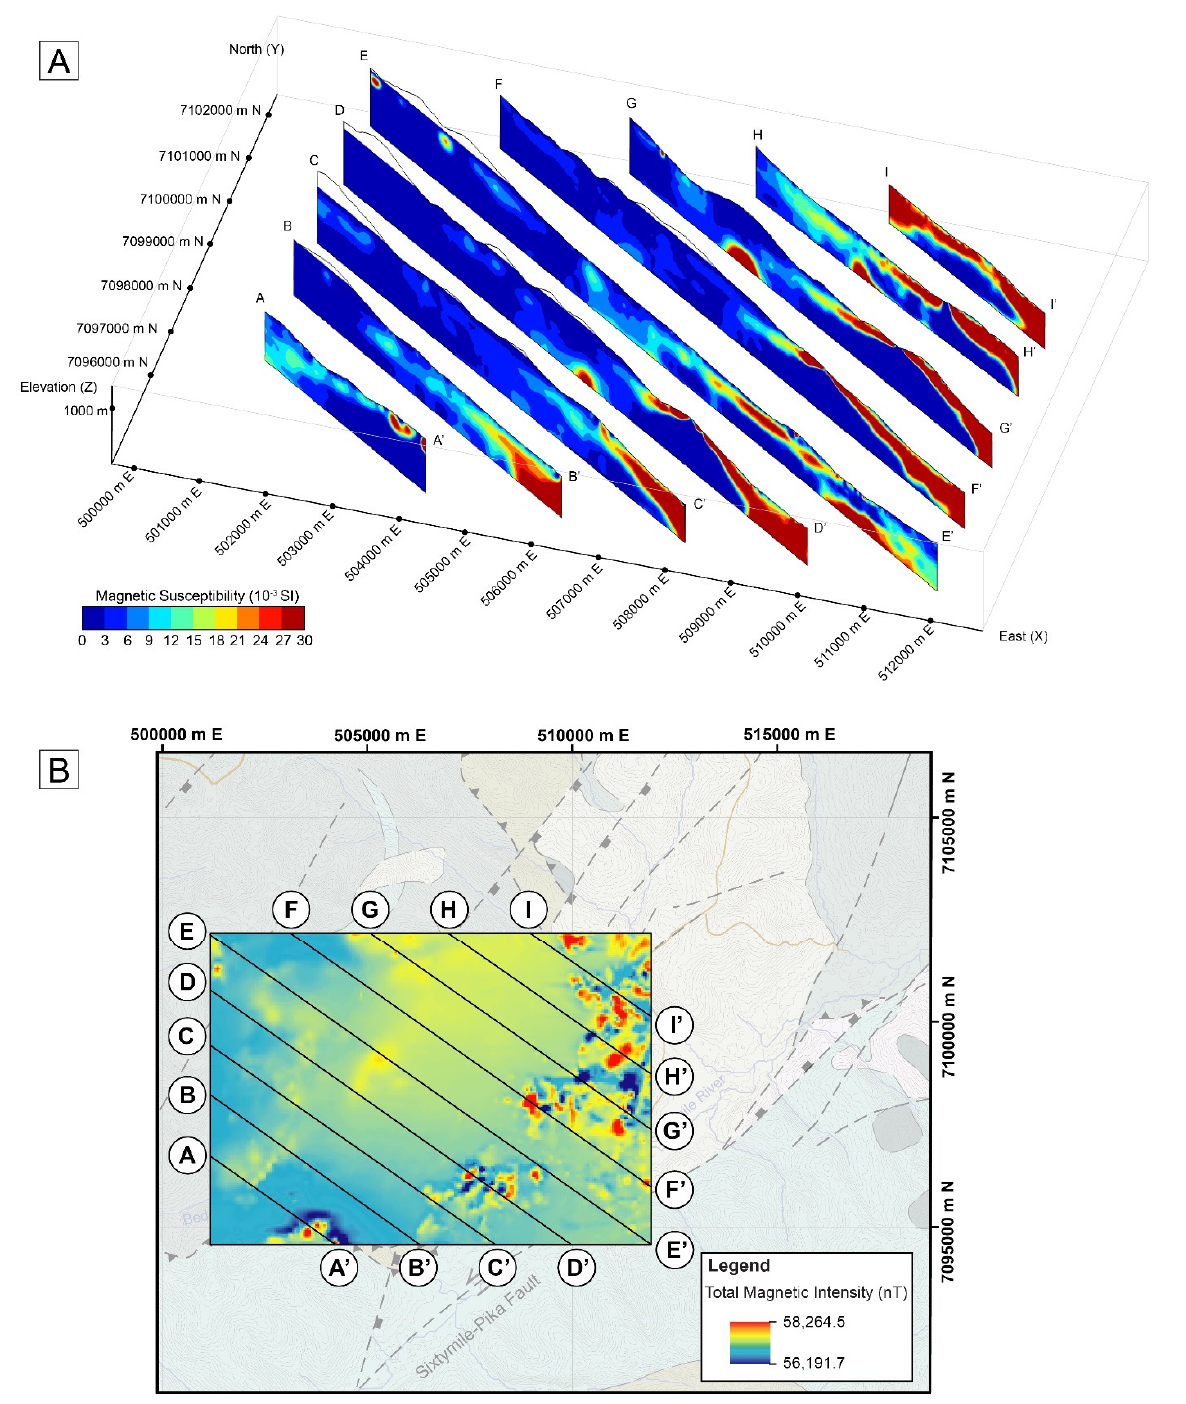
Figure 13. 3D magnetic susceptibility data. ( A ) Fence diagram of cross-sections through the 3D magnetic susceptibility data. ( B ) Map showing the locations of the cross-sections in ( A ) that are overlaid on the total magnetic intensity map on which the 3D inversion was conducted.